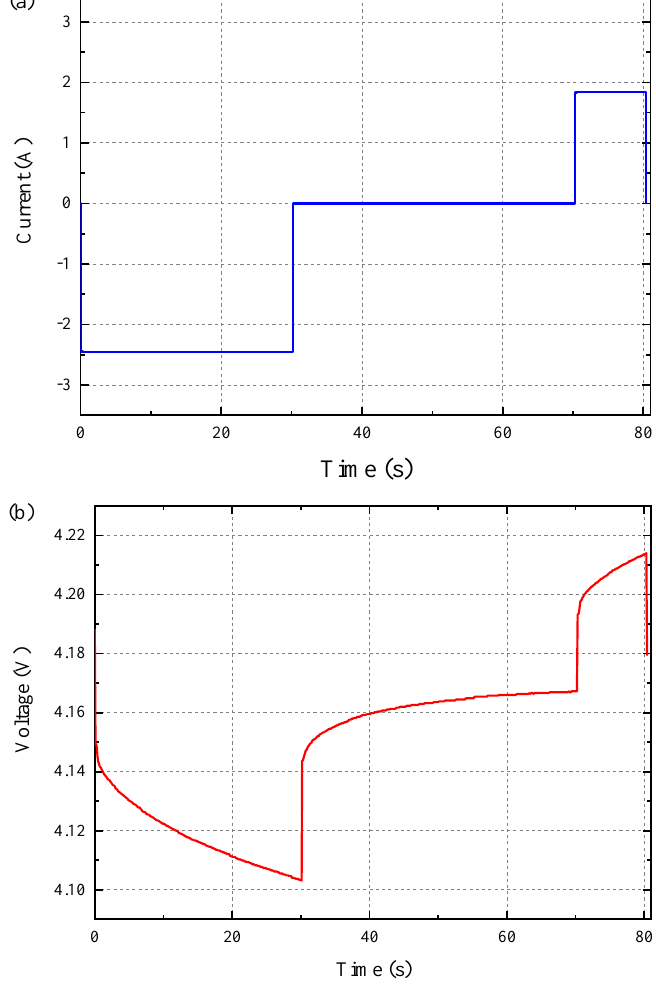
Figure 4. Current profile and voltage response of a hybrid pulse power characterization (HPPC) microcycle.